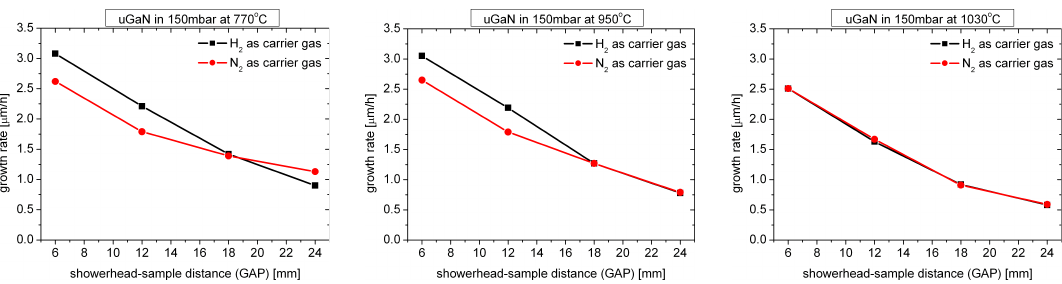
Figure 2. Growth rate of uGaN layers as a function of GAP distance for three different growth